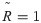
Sample beampattern for a cluster of N = 16 nodes and R˜=1 radius.